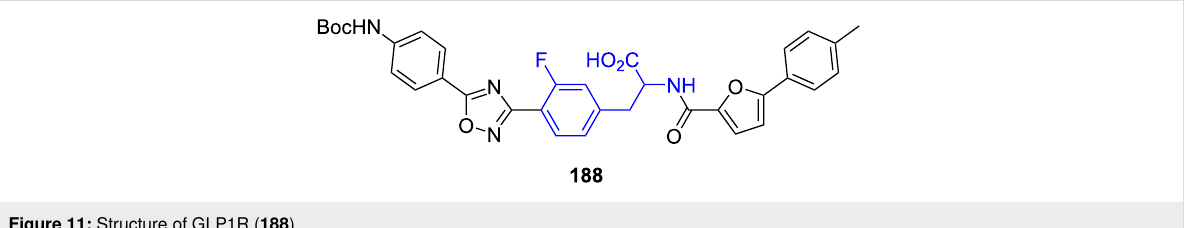
Figure 11: Structure of GLP1R ( 188 ).